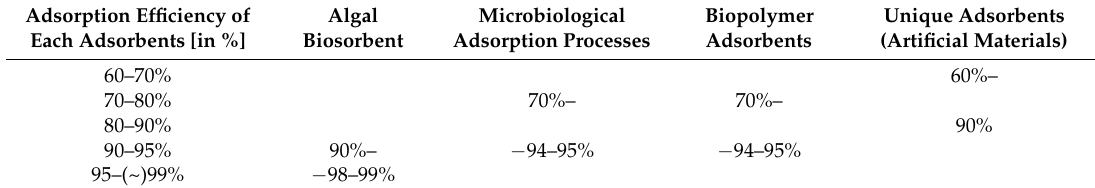
Table 2. Comparison of each adsorbents by heavy metal adsorption efficiency (edited by authors).